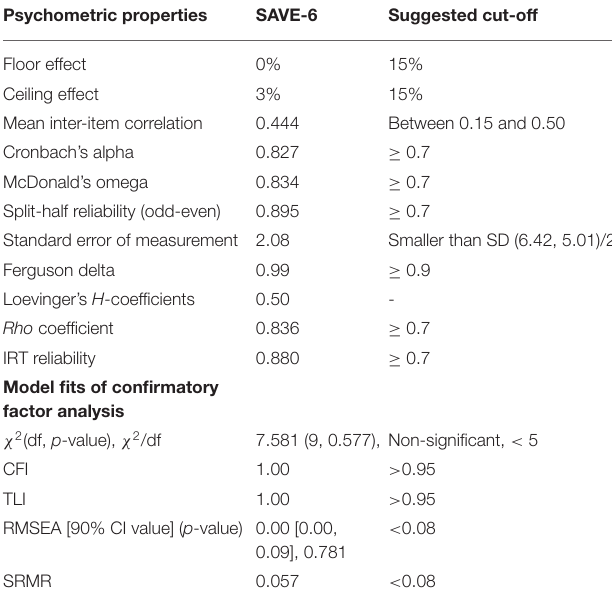
TABLE 3 | Scale-level psychometric properties of the